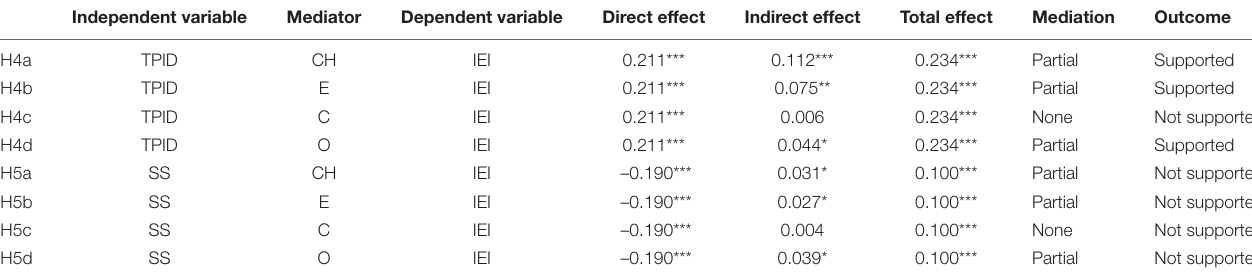
TABLE 6 | Test of mediation